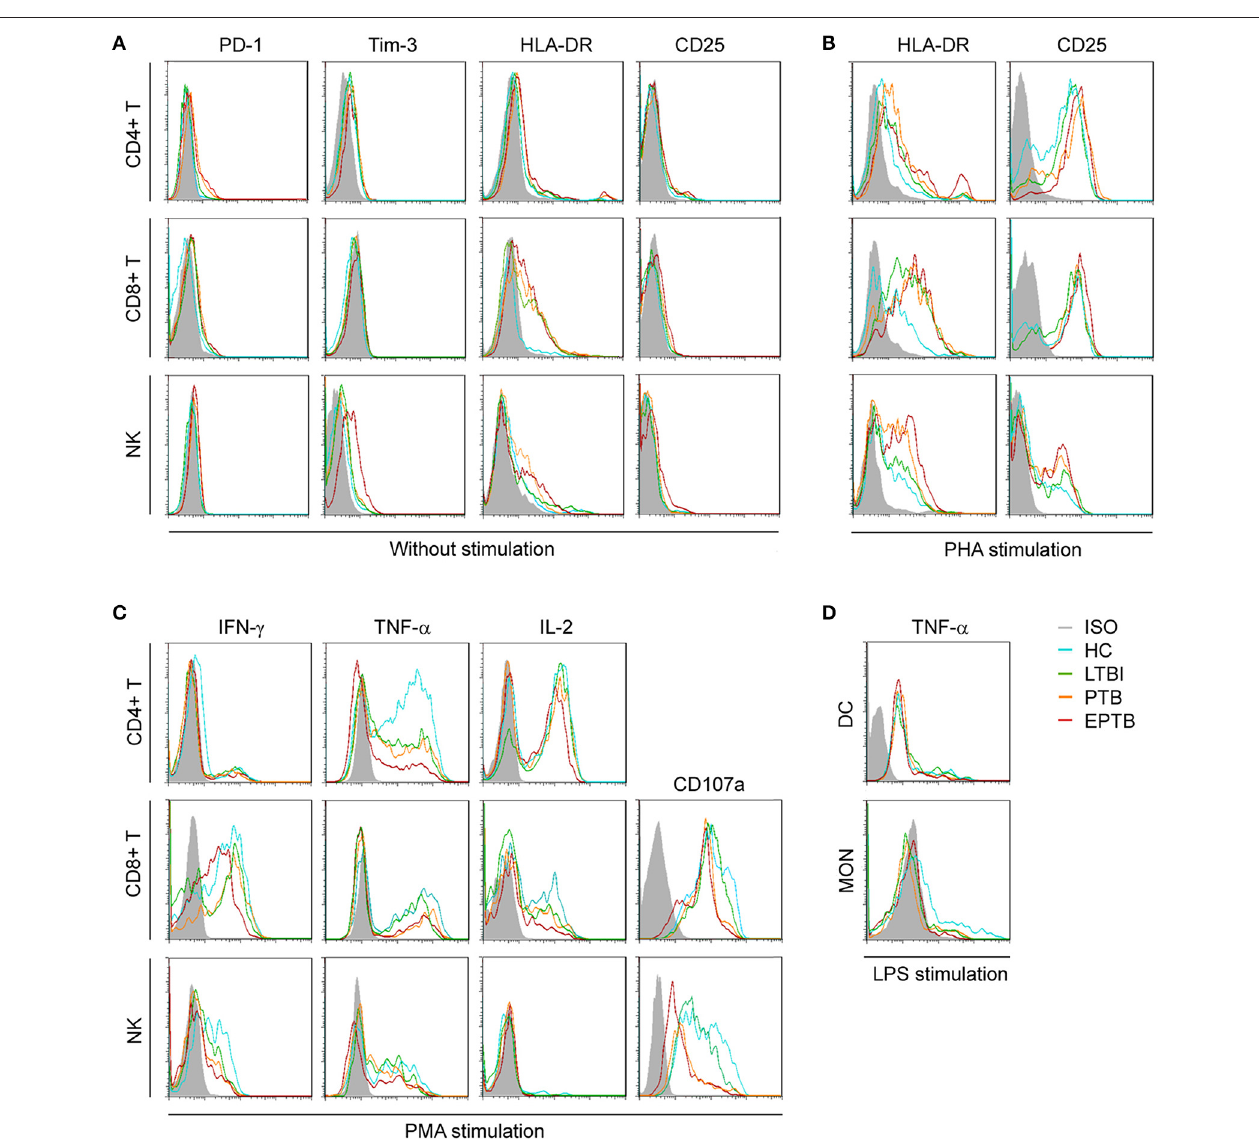
FIGURE 1 | Representative FACS histograms showing the expression of TB non-specific immunological markers. Inhibitory receptors (PD-1, Tim-3) (A) , activation receptors (HLA-DR, CD25) (A,B) , cytotoxicity marker (CD107a) (C) , and intracellular cytokines (IFN- γ , TNF- α , IL-2) on non-stimulated or PHA-, PMA-, or LPS-stimulated CD4 + T cells, CD8 + T cells, NK cells, DC, and MON (C,D) in HC, LTBI, PTB, and EPTB patients were evaluated by flow cytometer. ISO, isotype controls; HC, healthy controls; LTBI, latent tuberculosis infection; ATB, active tuberculosis; PTB, pulmonary tuberculosis; EPTB, extrapulmonary tuberculosis.